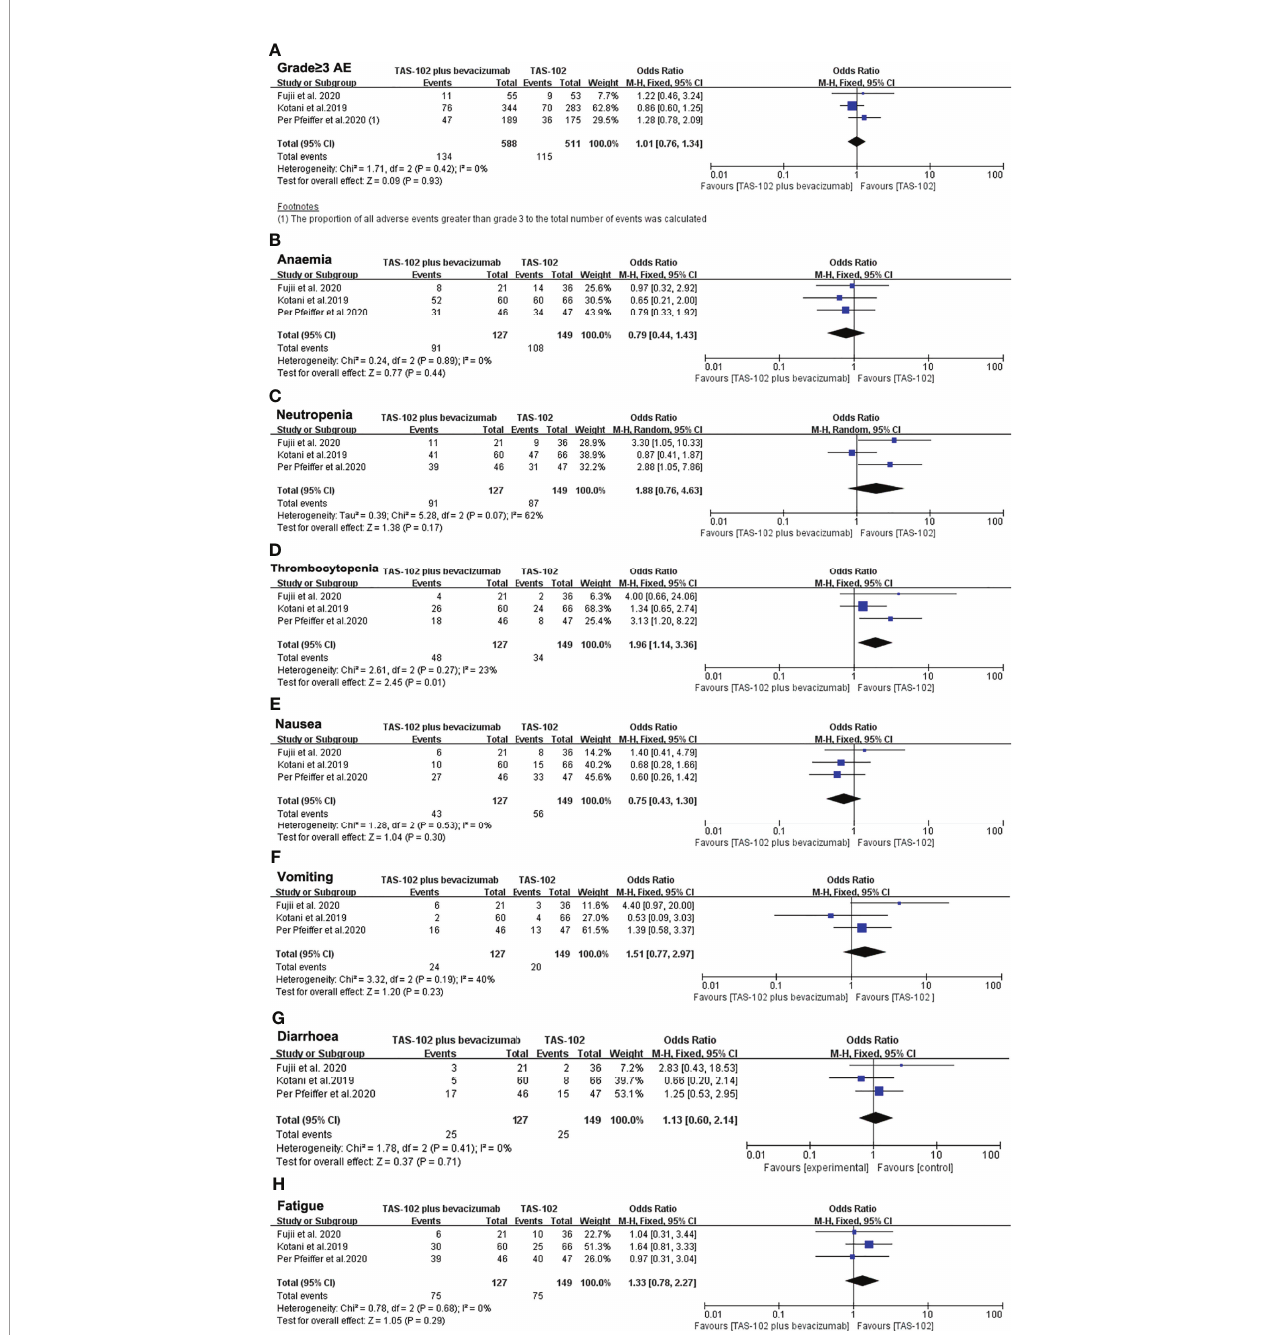
FIGURE 6 | Pooled analysis for adverse effects. (A) The incidence of sever AEs (grade ≥ 3), (B – H) represent the different side effects. Horizontal lines represent 95% con fi dence intervals (CIs). M-H, Mantel-Haenszel; df, degrees of freedom; AE, adverse